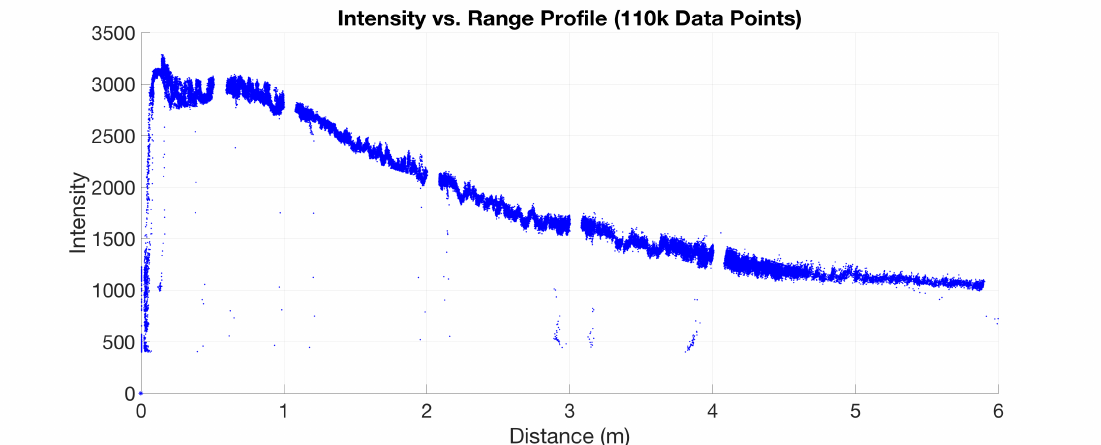
Figure 17. Range return intensity